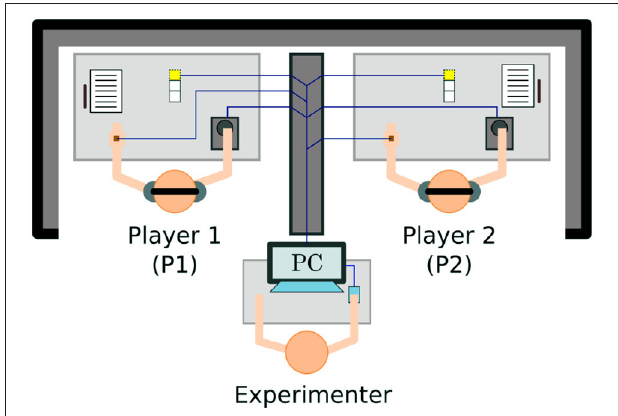
FIGURE 1 | Participants and experimenter in the Perceptual Crossing Paradigm. Copied from Froese et al. (2014a) under CC BY 3.0.